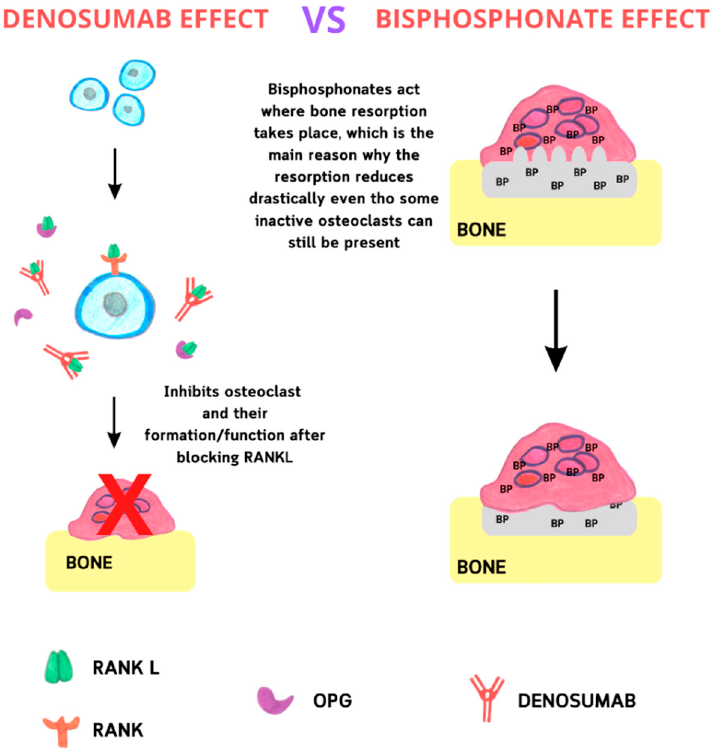
Figure 5. Effect of DB and BP on bone Figure 5. E ff ect of DB and BP on bone resorption.